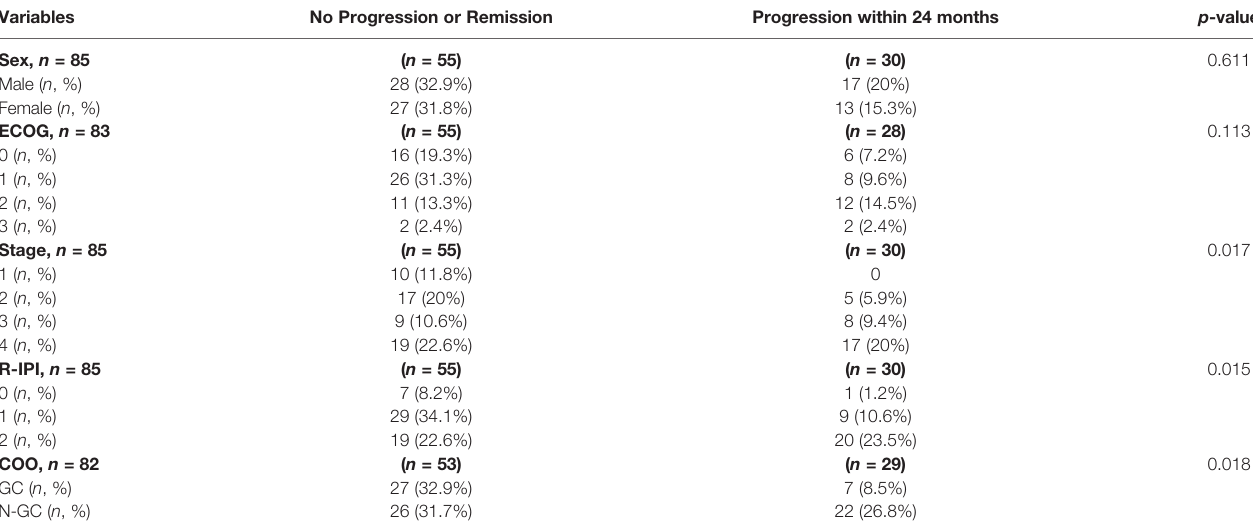
TABLE 1 | Comparison of clinical outcome of the patients and their clinical data. Variables No Progression or Remission